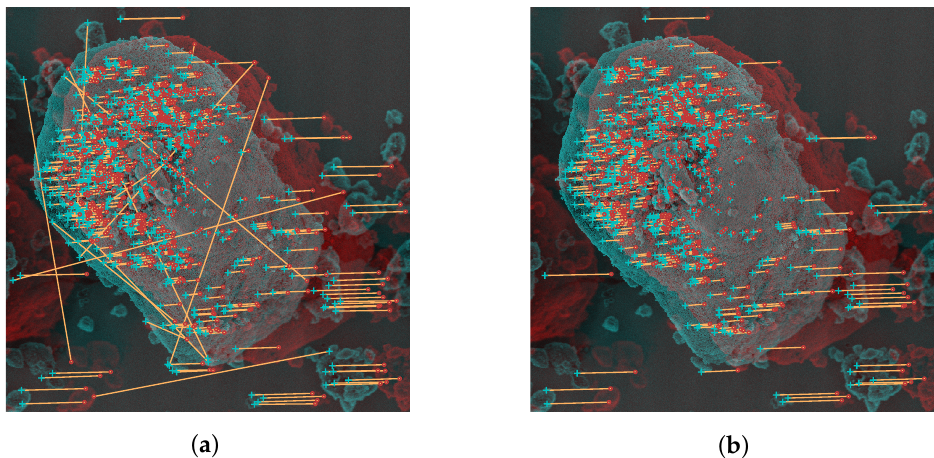
Figure 4. Exemplary anaglyph of a diesel exhaust particle (DEP) agglomerate ( ∆ ϕ Y = 15 ◦ ); ( a ) Initial descriptor-based matching (Th = 0.75), 711 matches; ( b ) Motion constraints ( ∆ y max = 25 px, ∆ x max = 200 px) and Maximum Likelihood Estimation Sample Consensus (MLESAC) with σ = 1 px, 617